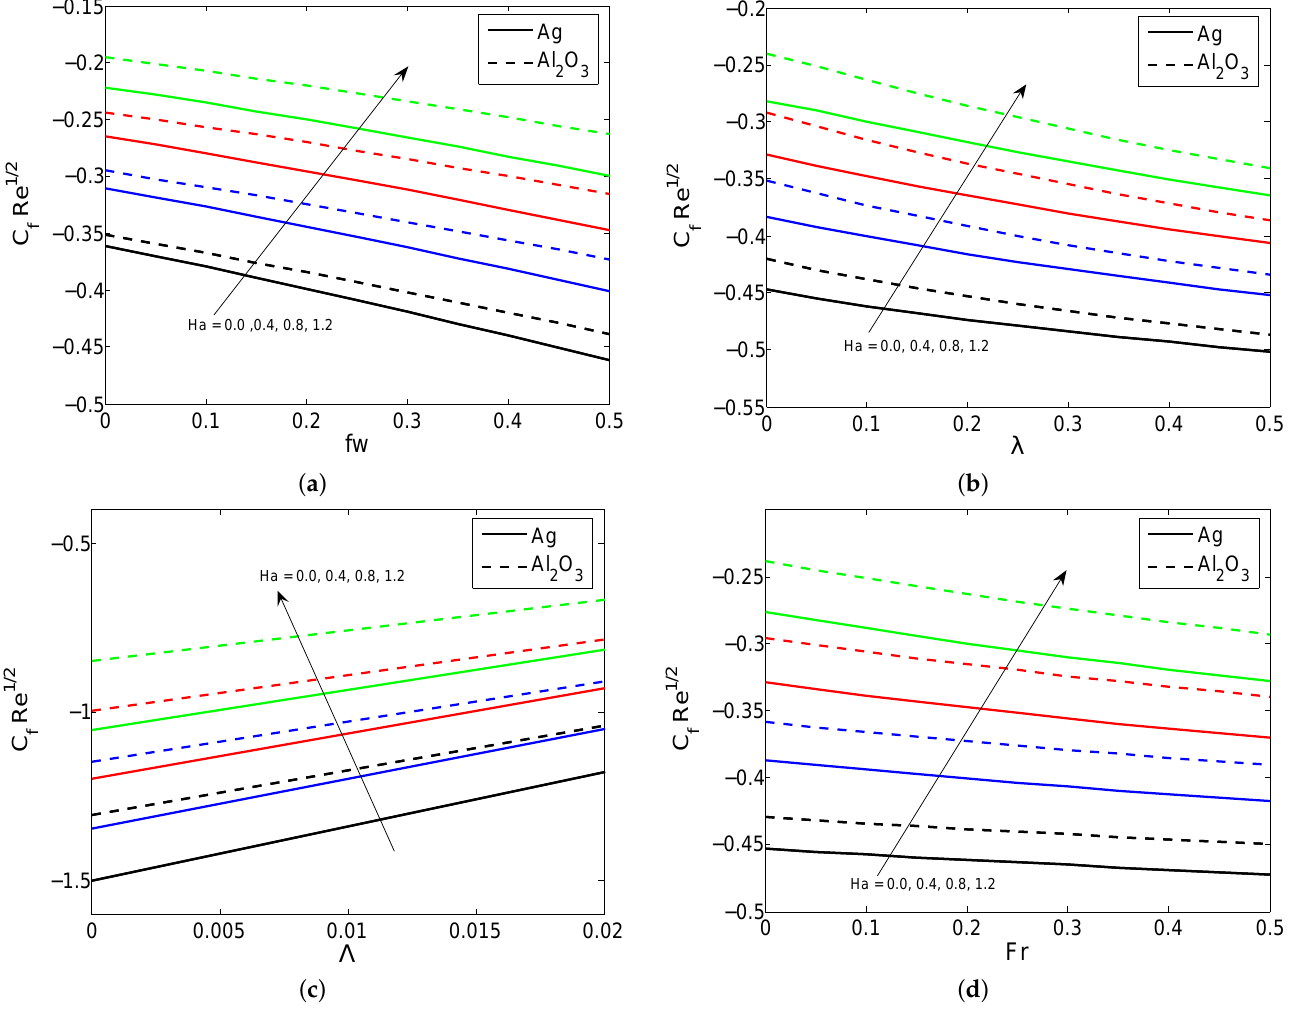
Figure 7. SFC variation for diverging values of ( a ) fw , ( b ) λ , ( c ) Λ and ( d ) Fr